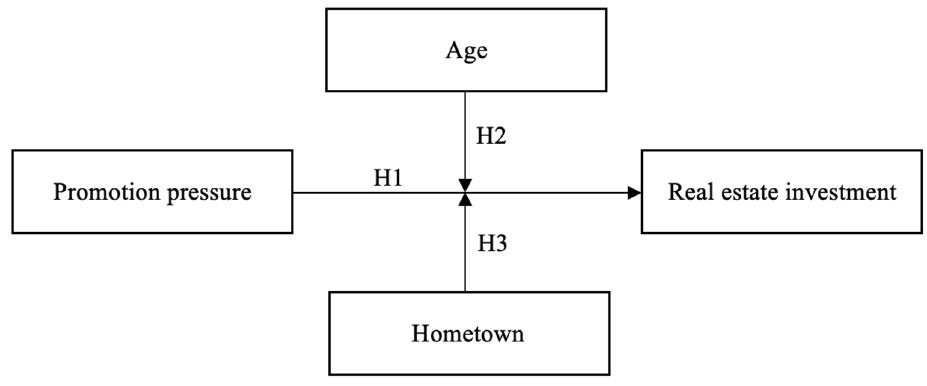
Figure 4. Theoretical framework.